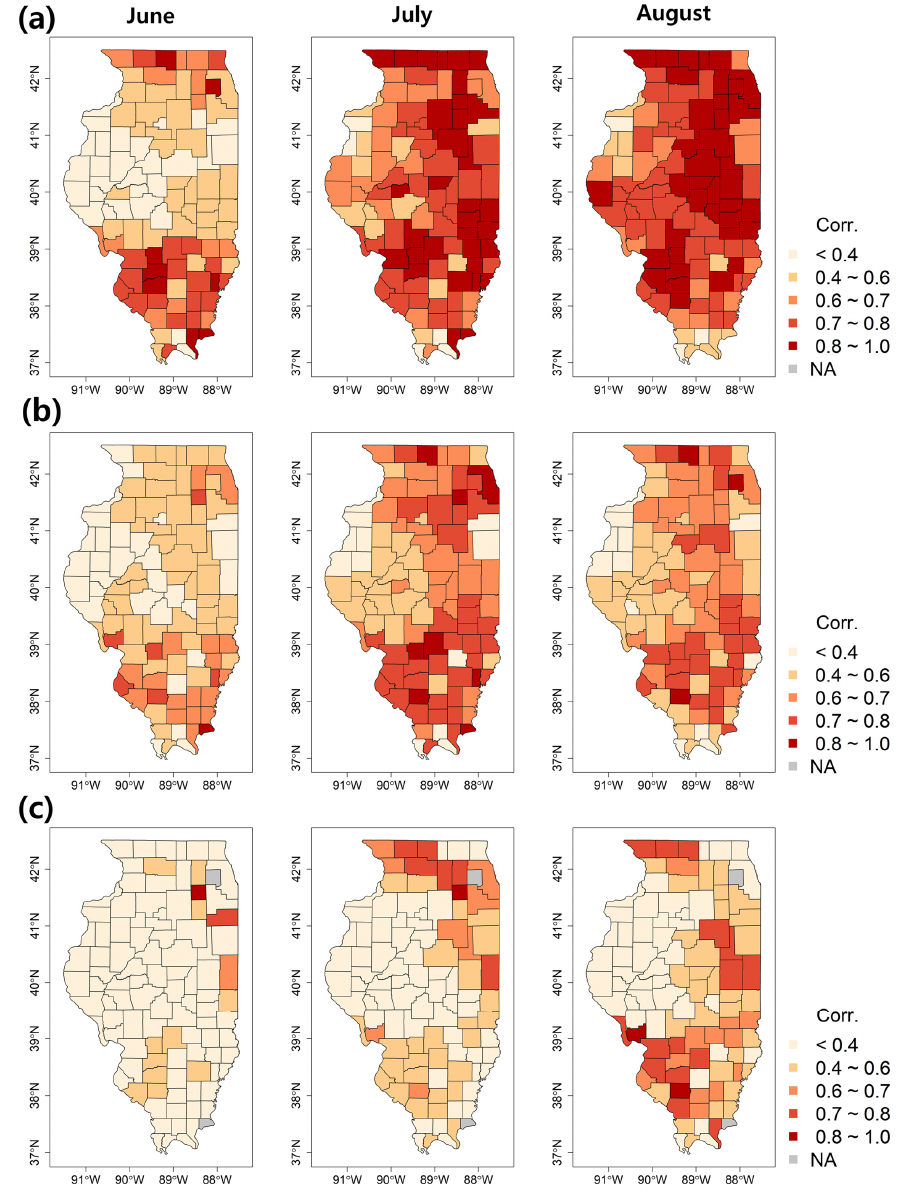
Figure 11. Distribution of the correlation between annual corn yields and the monthly average of ( a ) ICDI, ( b ) SDCI, and ( c ) VegDRI.